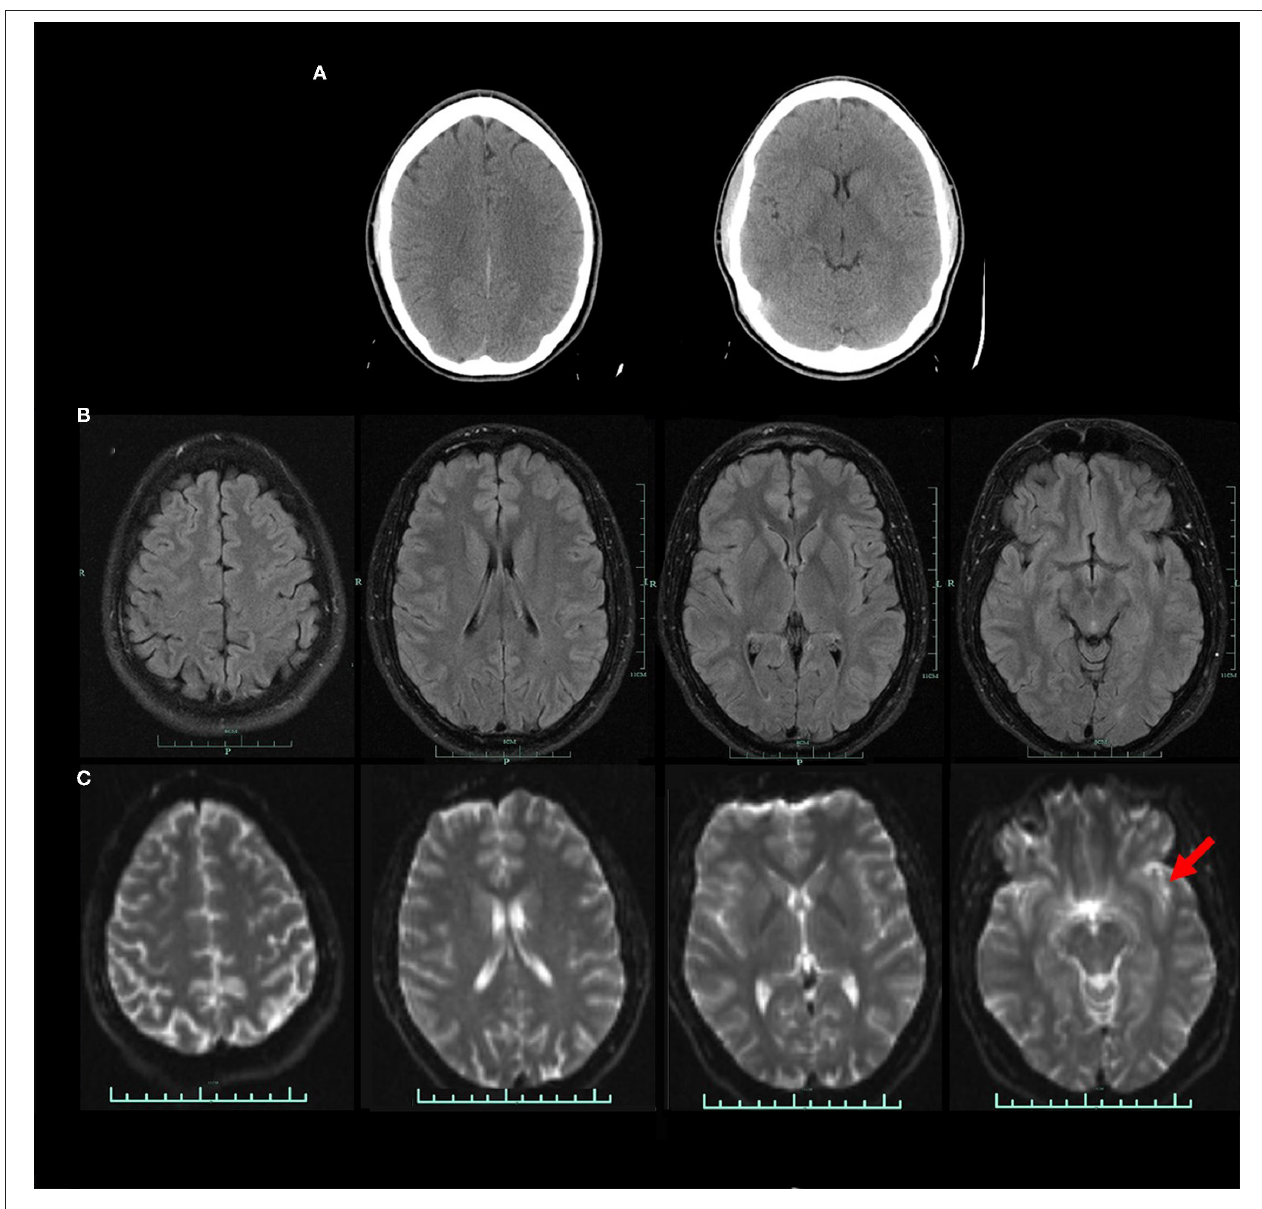
FIGURE 8 | (A) CT scan at two levels obtained in the acute setting. CT read as normal. (B) FLAIR protocol MRI at four levels. No abnormality visible. (C) DTI MRI at four levels. A small area of high signal is noted in the left temporal lobe (red arrow).